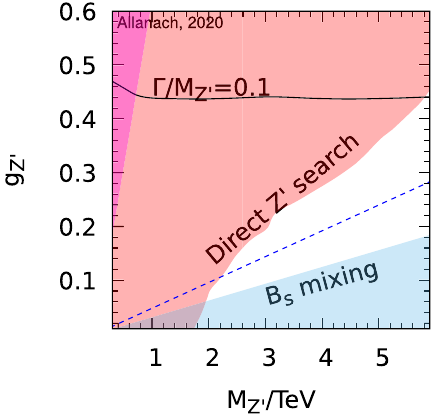
Fig. 8 Constraints upon ( B 3 − L 2 ) eg for M Z (cid:2) > 300 GeV. sin 2 θ sb has been set as in (18) such that every point fits the NCBAs. The white region is currently allowed. The red and blue coloured regions show the 95% excluded regions from a 13 TeV 139 fb − 1 ATLAS Z (cid:2) → μ + μ − search [77] and from B − B s s mixing as in (20), respectively. The latter bound moves from the blue coloured region at lower C 9 = − 0 . 65 to the region below the dashed line for central C = − 0 . 97. The 9 magenta region in the top left-hand corner shows the region ruled out by the neutrino trident process. The direct search bound is extrapolated above the solid curve and interpolated between ATLAS data below it, according to